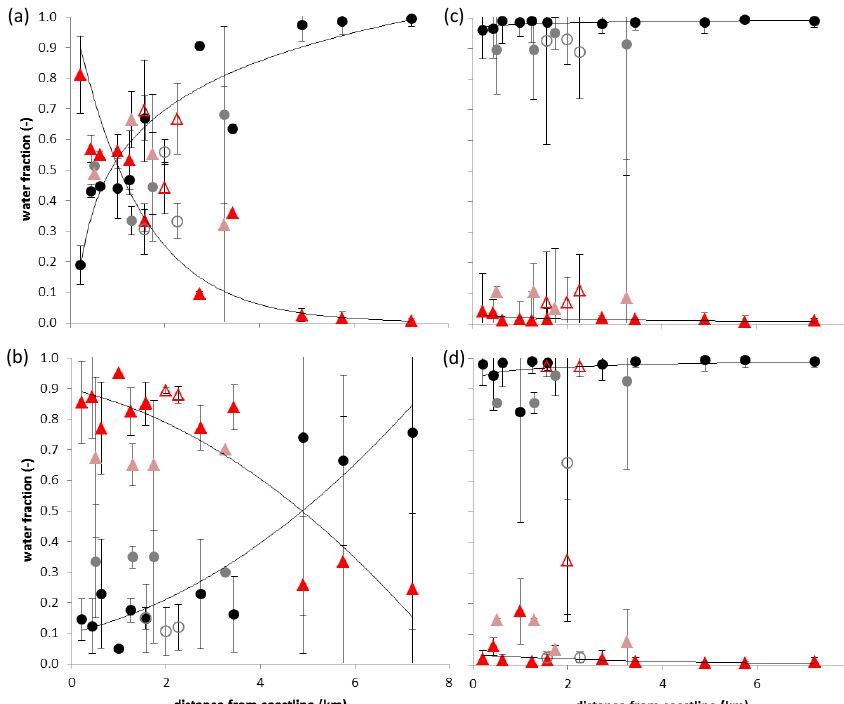
Figure 7. Changing fractions of freshwater (circles) and marine water (triangles) with distance from the coastline for (a) the top layer in the dry season, (b) bottom layer in the dry season, (c) top layer in the wet season, (d) bottom layer in the wet season; closed dark symbols indicate locations at the main lagoon channel, open symbols indicate surrounding lake locations and closed light symbols indicate their inflow/outflow connections to the lagoon system; error bars were determined from variability of endmember mixing analysis using salinity and chloride data individually in combination with δ 18